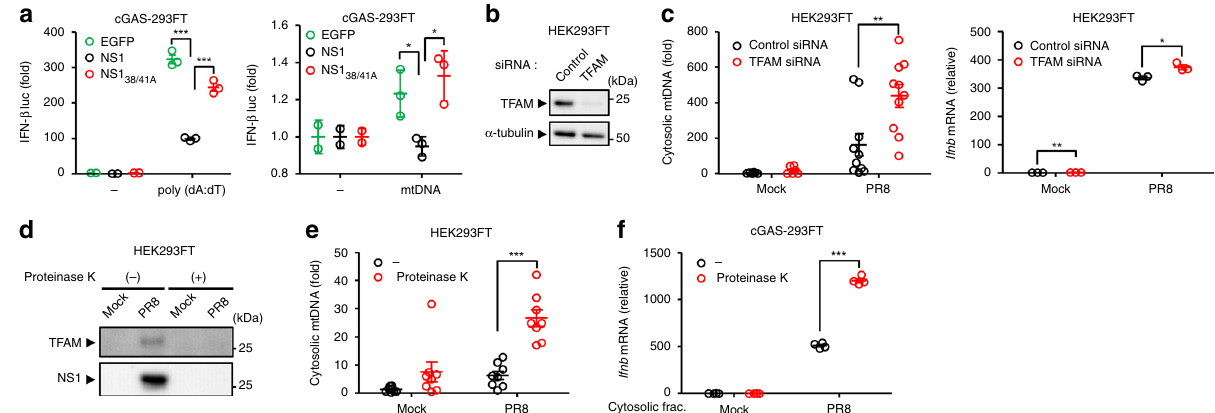
Fig. 7 NS1 binding to mtDNA attenuates its immunostimulatory potential. a cGAS-293FT cells co-transfected with expression plasmids encoding EGFP, Flag-tagged NS1, or NS1 38/41 mutant, together with IFN- β reporter plasmids and poly(dA:dT) (left panel) or mtDNA (right panel). Twenty-four hours after transfection, cell lysates were collected and analyzed for luciferase activity. b Samples from HEK293FT cells transfected with siRNA targeting TFAM or control siRNA were blotted using the indicated antibodies. c HEK293FT cells transfected with siRNA targeting TFAM or control siRNA were infected with PR8 virus for 24 h. Cytosolic mtDNA (left panel) and IFN- β mRNA levels (right panel) were assessed by quantitative PCR. d Pure cytosolic fraction prepared from digitonin extracts of mock- or PR8-infected HEK293FT cells were treated with proteinase K. Proteinase K-treated pure cytosolic extracts were analyzed by immunoblotting with indicated antibodies. e DNA was extracted from proteinase K-treated pure cytosolic fraction using QIAquick Nucleotide Removal kit (QIAGEN). Cytosolic mtDNA was assessed by quantitative PCR. f cGAS-293FT cells were transfected with DNA extracted from proteinase K-treated pure cytosolic fraction for 6 h. IFN- β mRNA levels were assessed by quantitative PCR with β -actin as an internal control. These data are from three independent experiments ( a , c , e , f ; mean ± s.e.m.). * P < 0.05, ** P < 0.01, *** P < 0.001; (one-way ANOVA and Tukey ’ s test). Source data